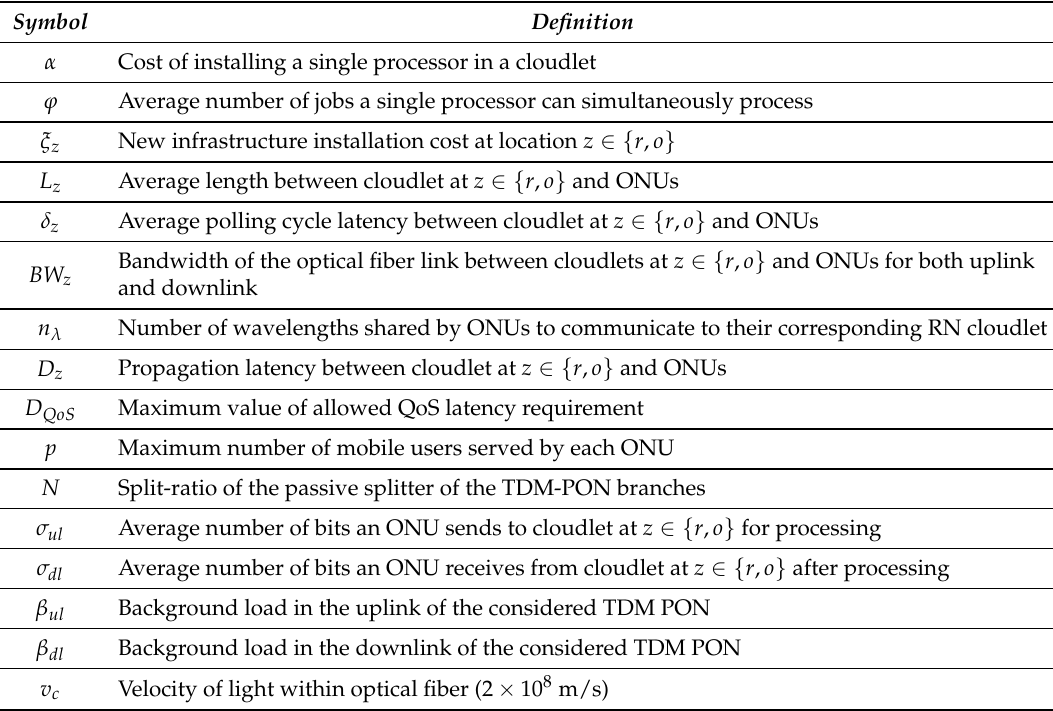
Table 1. Network optimization